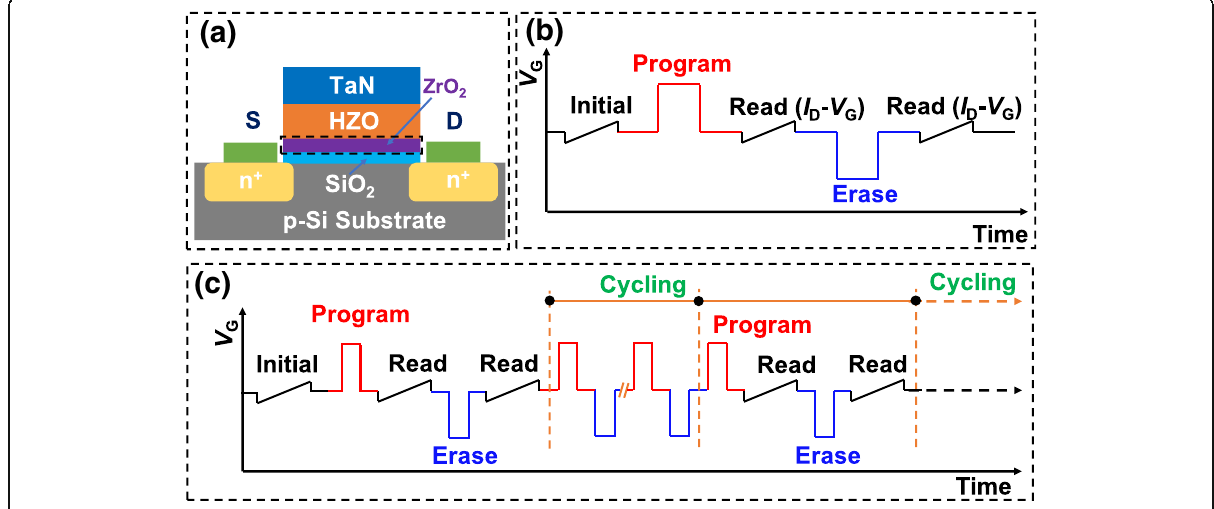
Fig. 1 a Schematic of the fabricated FeFETs. The additional crystalline ZrO 2 seed layer is marked by black gridlines. b , c Test sequences used for MW and endurance